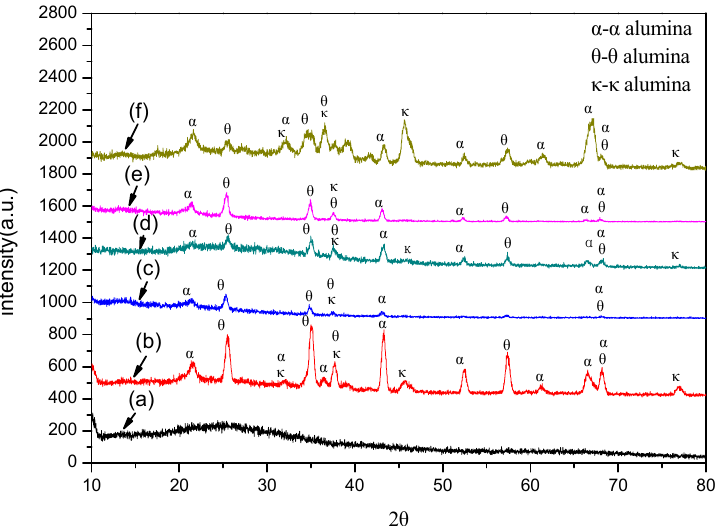
Figure 4. XRD patterns of ( a ) anodic, ( b ) MAO and APD coatings at ( c ) discharge time 5 min, duty cycle 10% and current density 100 mA/cm 2 ( d ) discharge time 15 min, duty cycle 15% and current density 100 mA/cm 2 ( e ) discharge time 15 min, duty cycle 10% and current density 200 mA/cm 2 ( f ) discharge time 25 min, duty cycle 20% and current density 500 mA/cm 2.